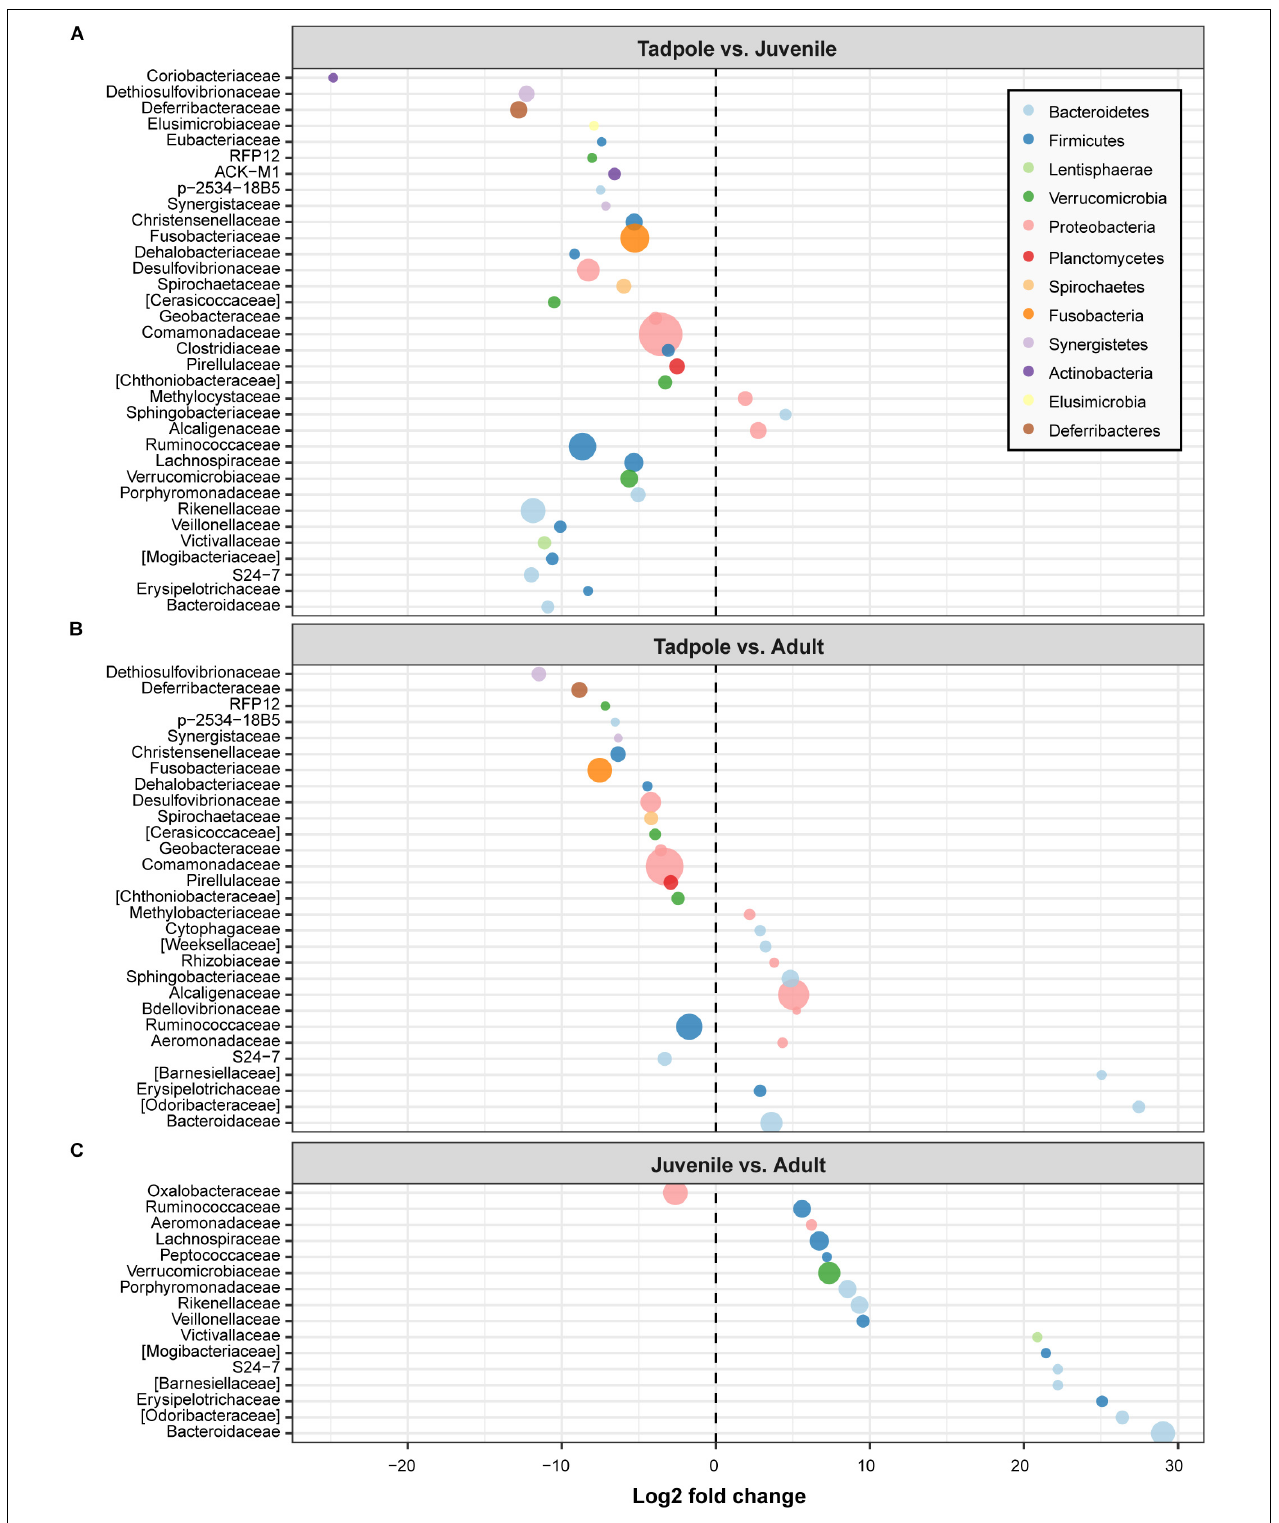
FIGURE 5 | Fold changes of identified bacterial families (circles) that differed between life stages. (A) Tadpole vs. juvenile, (B) Tadpole vs. adult, and (C) Juvenile vs. adult. Bacterial families with a log2 fold change less than 0 were more abundant in the life stage indicated on the left, whereas those with a log2 fold change higher than 0 were more abundant in the indicated life stage on the right. Bacterial families are colored by phylum and sized by mean relative abundance across samples.